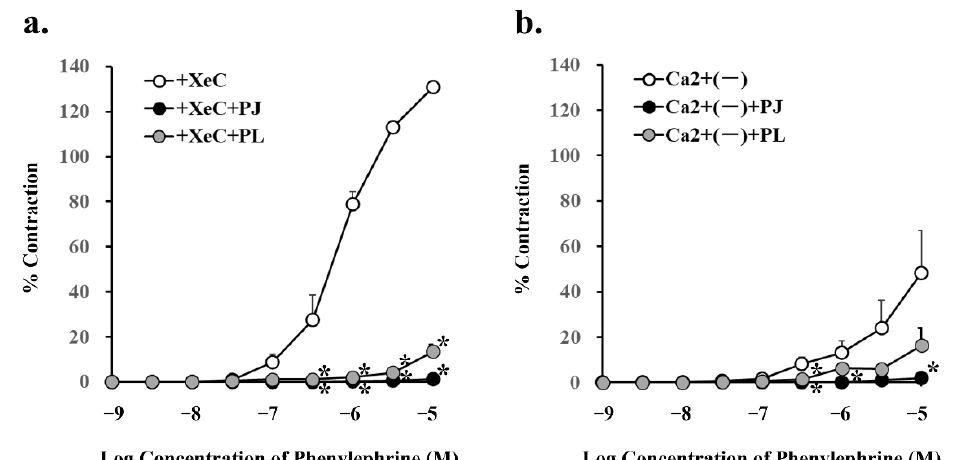
Figure 6. Concentration–response curves for phenylephrine-induced vasocontraction in the absence (control) or presence of pretreatment with persimmon juice (PJ) (1 g/L) and persimmon leaf (PLs) (1 g/L) powder in rat superior mesenteric artery rings ( n = 4–6). ( a ) The curves were constructed for experiments in the presence of xestospongin C (XeC; 0.5 µM) and ( b ) in the absence of Ca 2+ . Results (mean ± standard error of mean) are expressed as a percentage of the previous tone induced by potassium chloride (60 mM). * p < 0.05 vs. each control (Dunnett’s test). Table 3. Effects of persimmon juice (PJ) and persimmon leaf (PLs) pretreatment on phenylephrine- induced vasocontractions in the presence of xestospongin C (XeC) or in the absence of Ca 2+ in rat superior mesenteric artery rings.